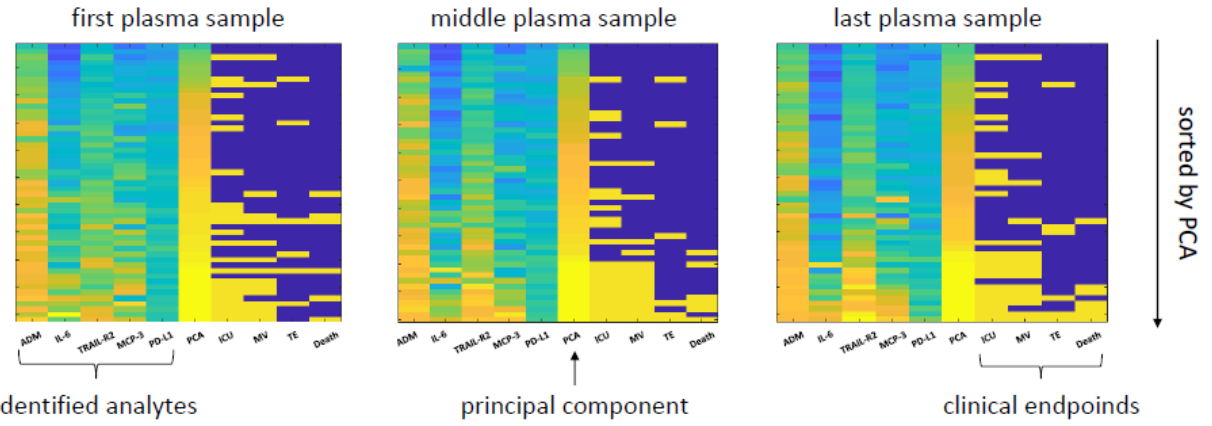
Figure 5. Heat map of predictive performance—the heat map presents the relative values of the five selected analytes (ADM, IL-6, MCP-3, TRAIL-R2, PD-L1) and the corresponding principal component analyses (PCA, as a combination of these markers) in relation to four clinical events (ICU treatment, TE, MV, and death). The first heat map (left) presents values based on plasma taken initially in the ED. The middle heat map presents values from the plasma sample at the middle of the hospital stay, and the last heat map plasma sample from the latest time point (either prior to discharge of the patient or before fatal outcome). The samples are sorted according to the value of PCA.